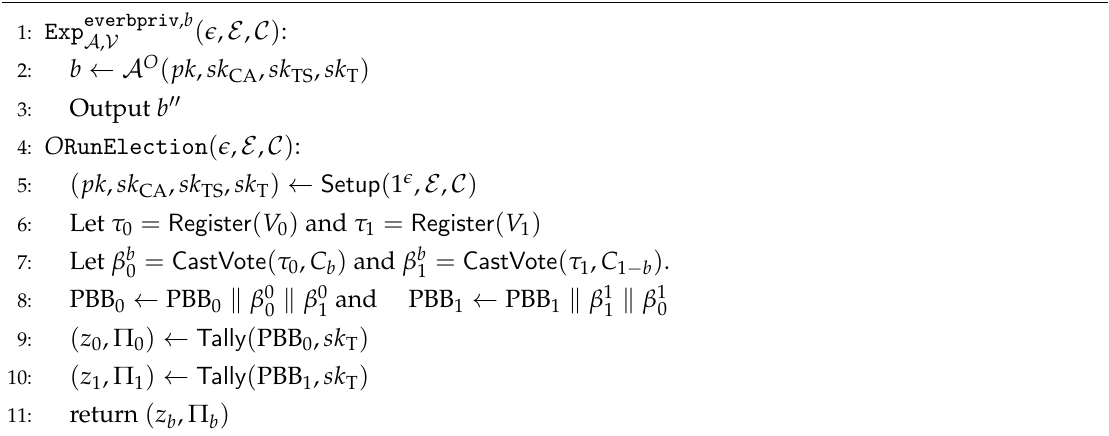
Algorithm 2 In the practical everlasting privacy game, Exp the oracle O = { O RunElection } . In this scenario, the setup needs to happen inside the oracle, so that the voter identifiers are